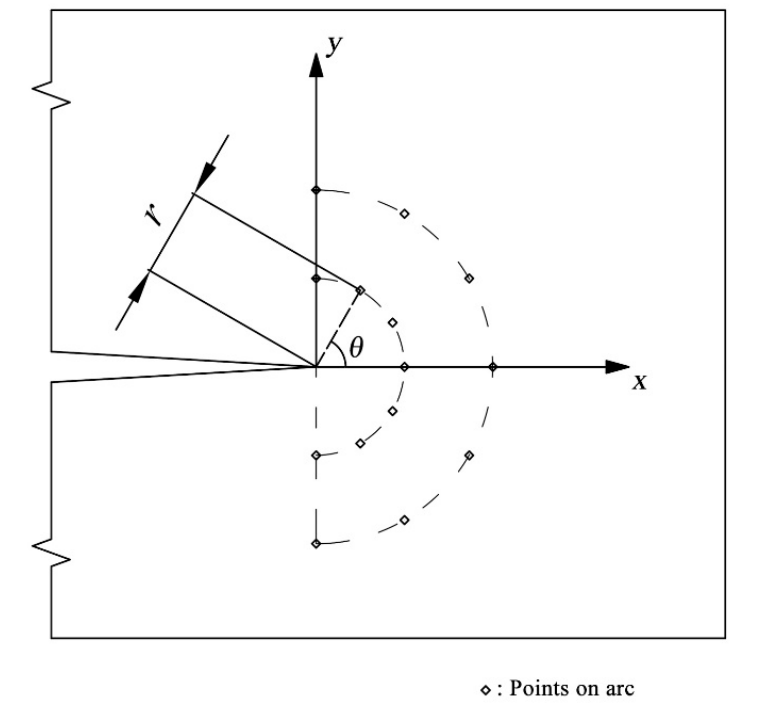
Figure 12. Arc in front of the crack tip for a comparison between stress values from analytical (SIF) and numerical results.